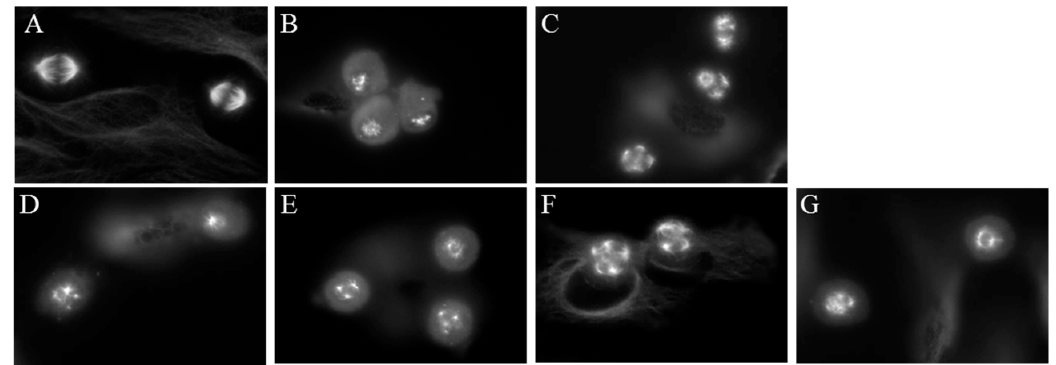
Figure 6. Effects of the Janus compounds on mitotic spindles. HeLa cells were treated for 18 h and then microtubules visualized by indirect immunofluorescence: ( A ) vehicle-treated cells; ( B , C ) the effects of the positive controls paclitaxel (100 nM) and CA-4 (5 nM), respectively; and the effects of the Janus compounds: ( D ) 25 μ M 1 ; ( E ) 25 μ M 2 ; ( F ) 8 μ M 3 ; and ( G ) 10 μ M 4 .